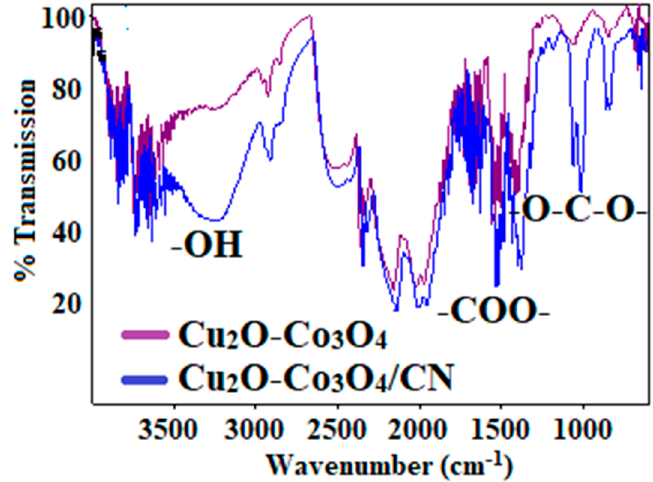
Figure 2. FTIR of Cu 2 O-Co 3 O 4 and Cu 2 O-Co 3 O 4 /CN composites.